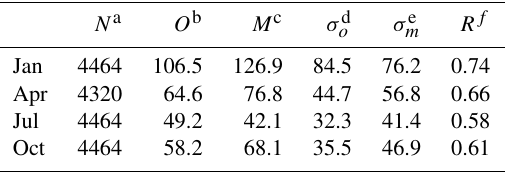
Table 1. Statistical summary of the comparisons of the monthly average PM 2 . 5 between simulation and observation.